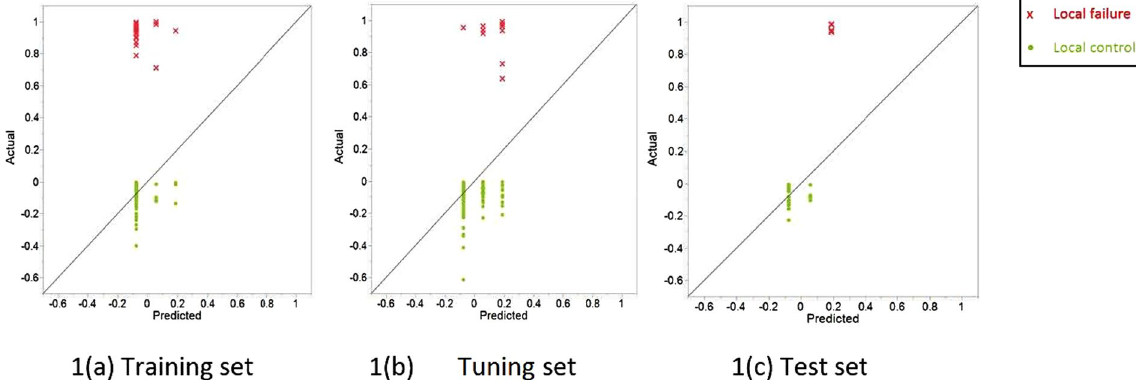
Figure 1. ‘Actual Martingale residual’ by ‘predicted value from random forest’ plot of time-to-local failure for the three sets based on the radiomic signature.